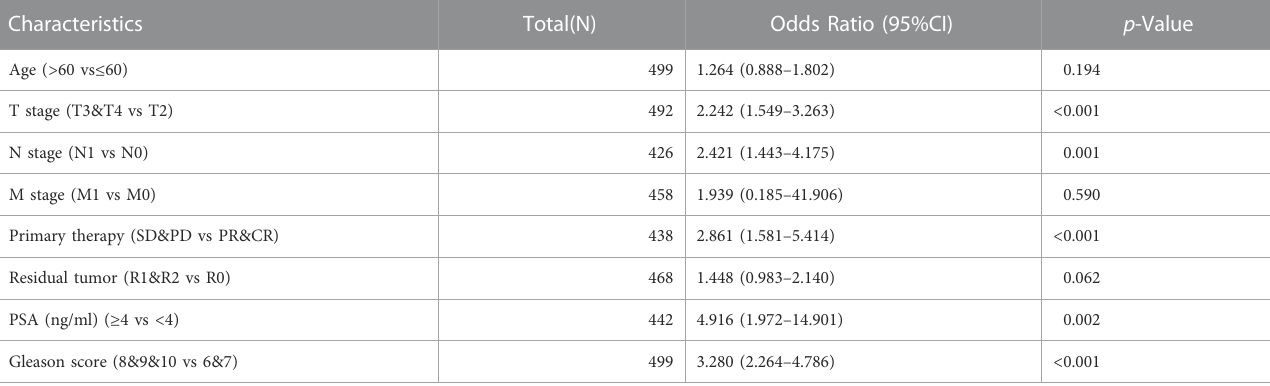
TABLE 1 Association between KNL1 expression and clinicopathologic parameters by Logistic regression.